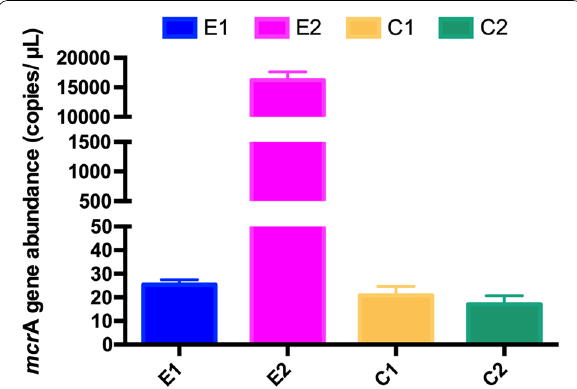
Fig. 4 The mcrA gene abundance in enrichment cultures (column blue: E1; pink: E2; yellow: C1; green:C2) amended with long‑chain n